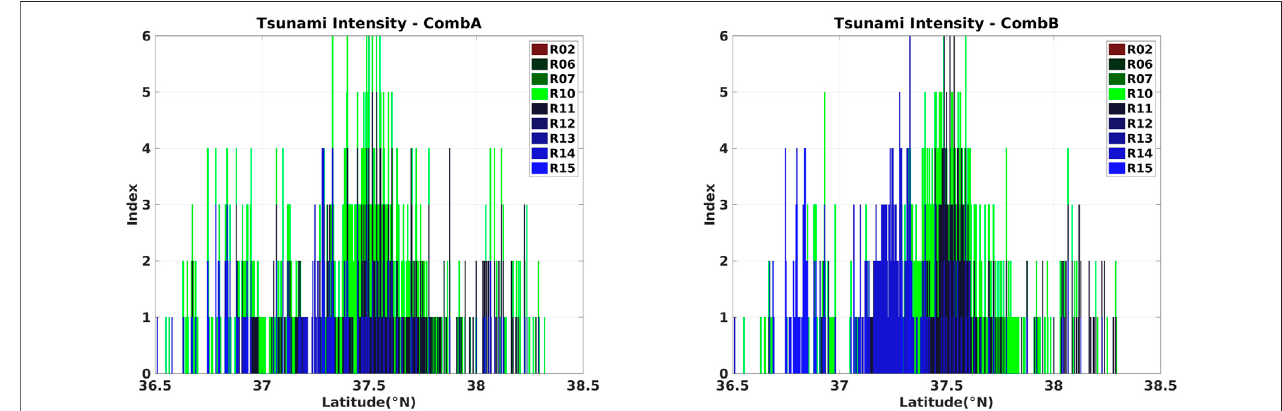
FIGURE13| Estimated indexoftsunamiintensityfortheeasterncoastoftheKorean Peninsulafor11scenarios( “ R ” )and 2combinations[ (A) :CombinationA; (B) : Combination B] of fault parameters.